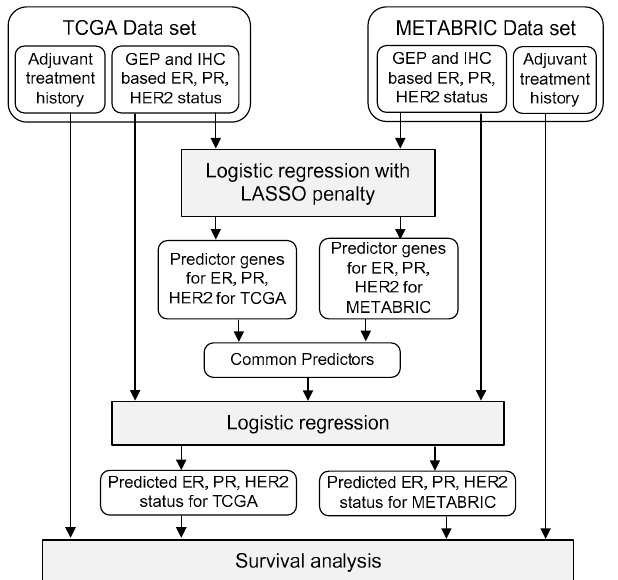
Figure 6. Workflow of gene selection, model training, receptor-status prediction, and survival analysis.